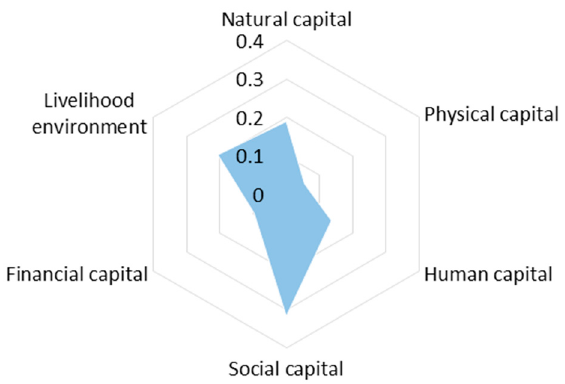
Figure 3. Comprehensive index of adaptability of rural households in earthquake-stricken areas.